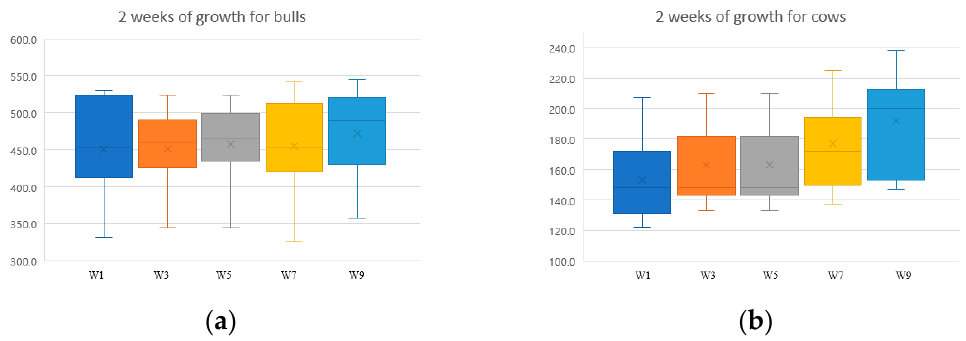
Figure 13. Boxplot for growth cattle weight of males and females: ( a ) male cattle; ( b ) female cattle.